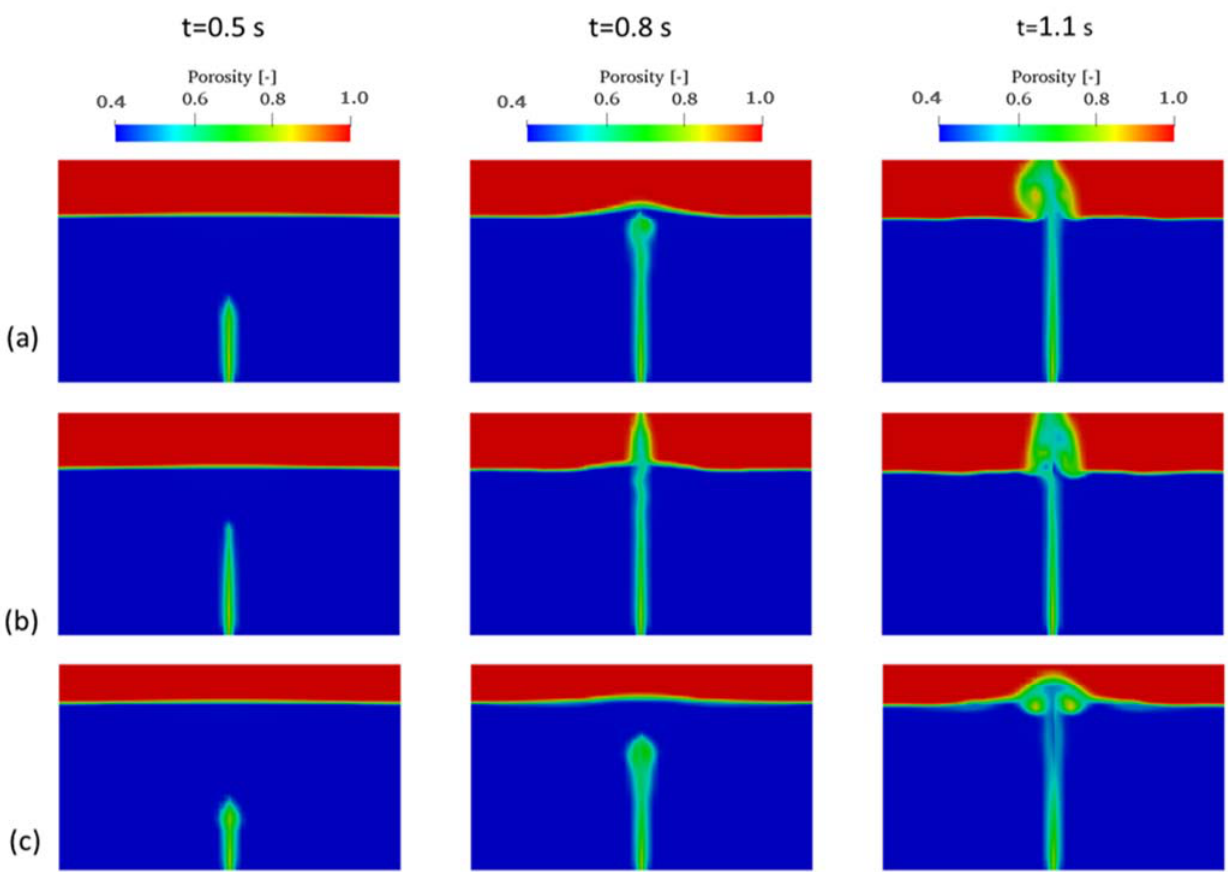
Figure 9. Porosity distribution over the sand bed at times 0.5, 0.8, and 1.1 s for particle distributions ( a ) PSD1, ( b ) PSD2, and ( c ) PSD3.